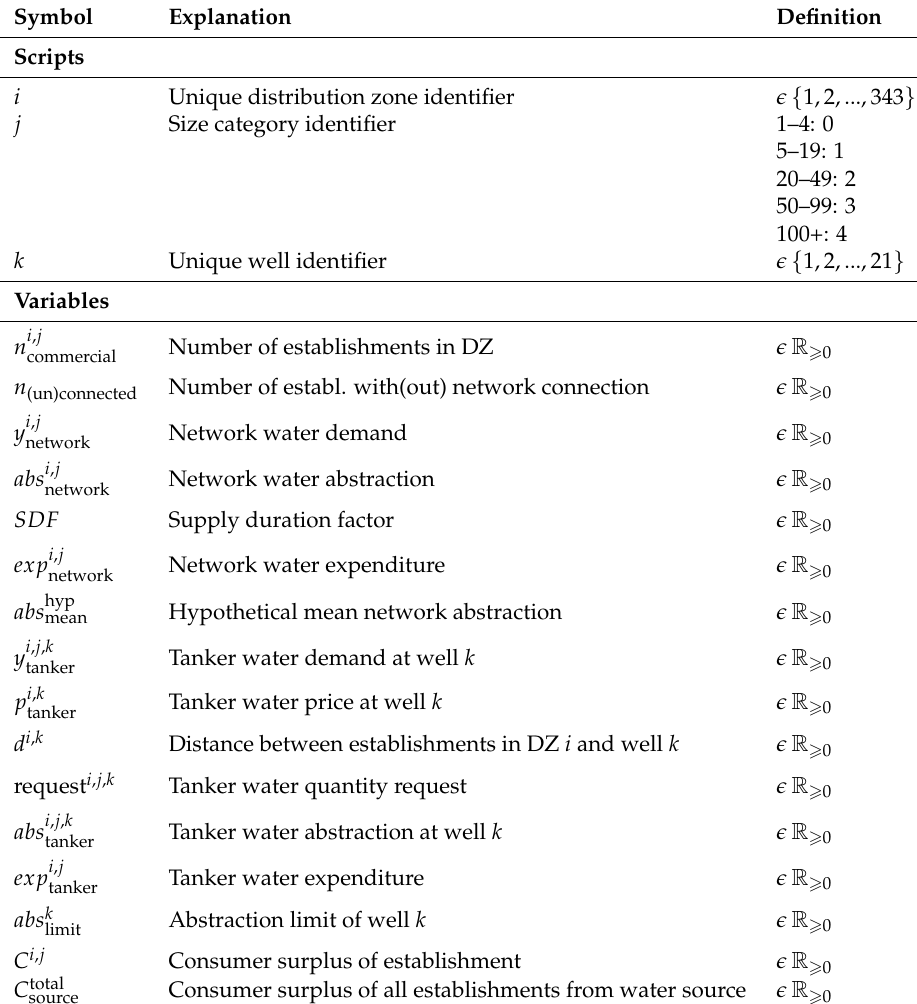
Table A1. Model variables, sub- and